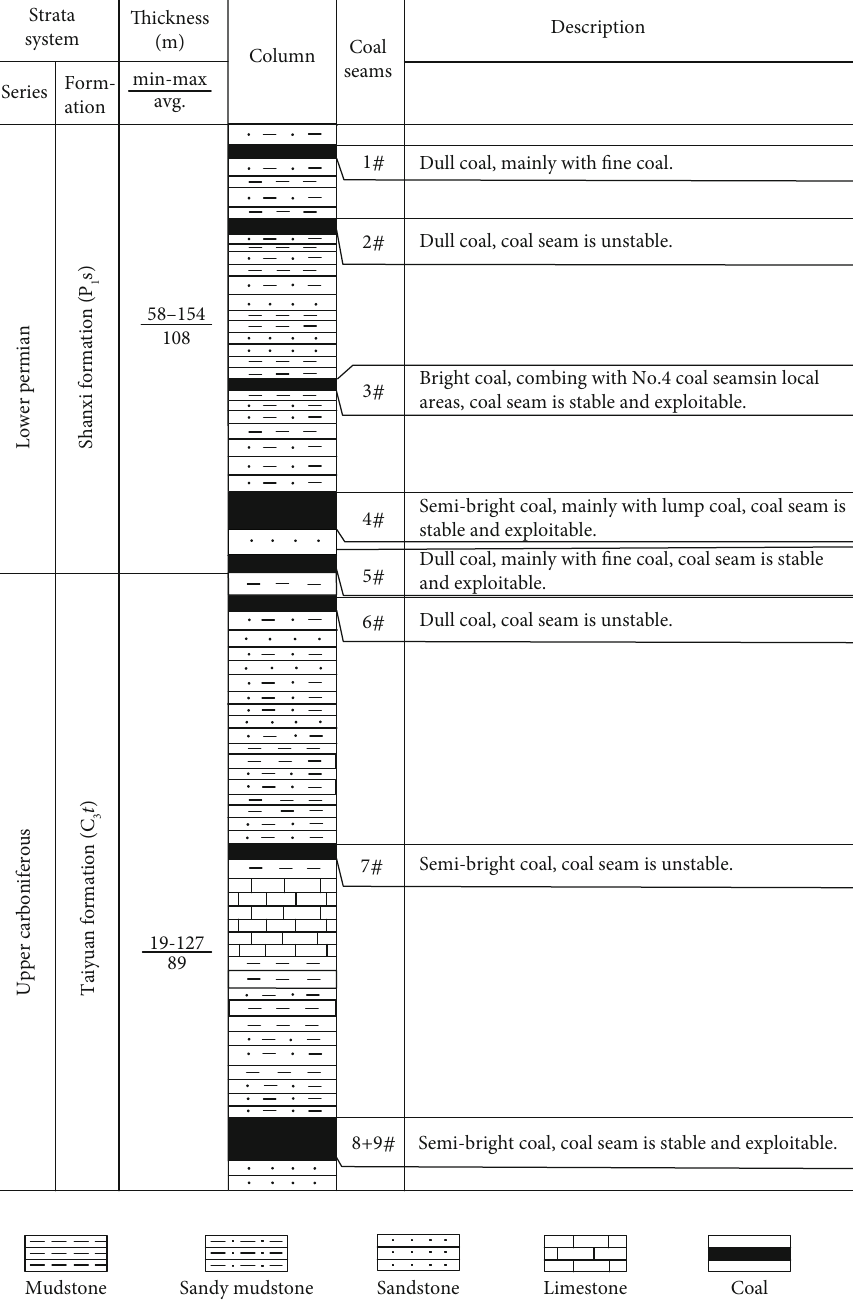
Figure 2: Stratigraphic column of Permo-Carboniferous coal-bearing sequences in Yangjiapo